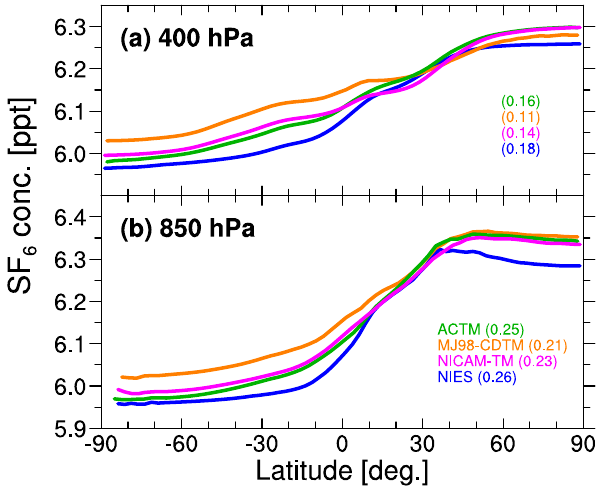
Fig. 2. Latitudinal distributions of annual zonal mean of SF 6 con- centrations at 400hPa (a) and 850hPa (b) , simulated by ACTM (green), MJ98-CDTM (orange), NICAM-TM (magenta), and NIES (blue). Parenthetical values represent differences of area-weighted mean SF 6 concentrations between in the Northern and Southern Hemispheres. The global constant offset of 4.7ppt is added to the simulation results according to the estimate by ESRL/NOAA for the global average at the beginning of the